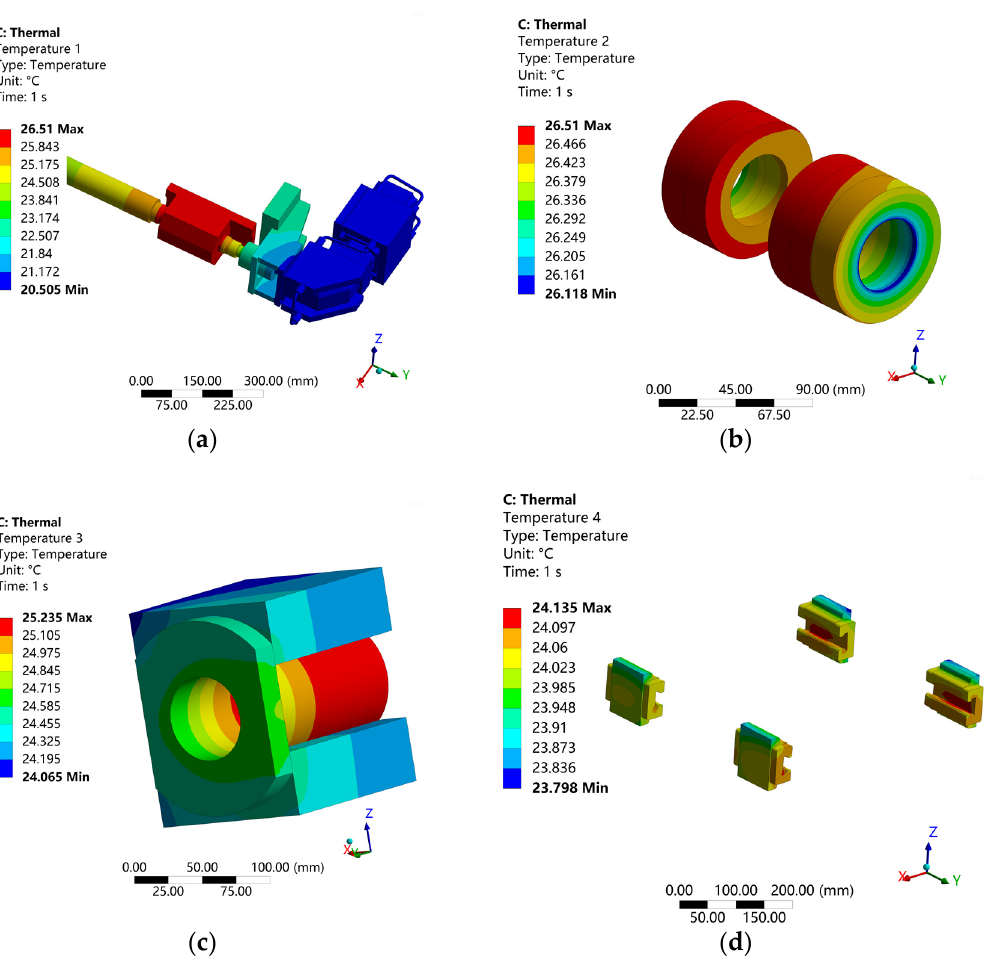
Figure 15. Temperature of the key components in a vacuum environment: ( a ) Motor side temperature rise diagram; ( b ) Bearing set temperature rise diagram; ( c ) Nut temperature rise diagram; ( d ) Slider temperature rise diagram.